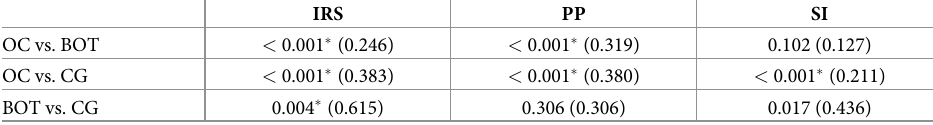
Table 2. Summarized p -values (effect sizes in brackets) of compared CA XII expression between the cohorts. IRS PP SI OC vs. BOT